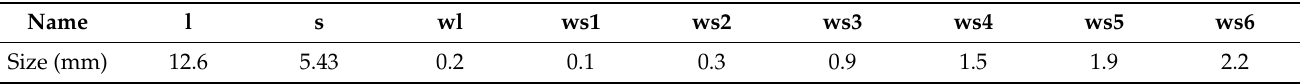
Table 1. Geometric parameters of grid antenna.